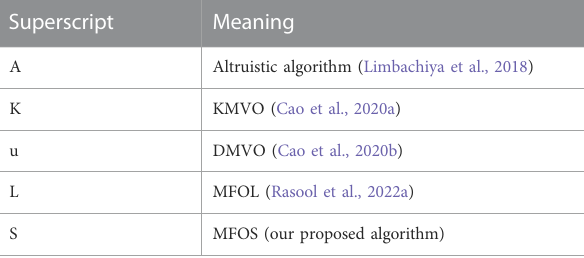
TABLE 2 Superscript identi fi cations and their